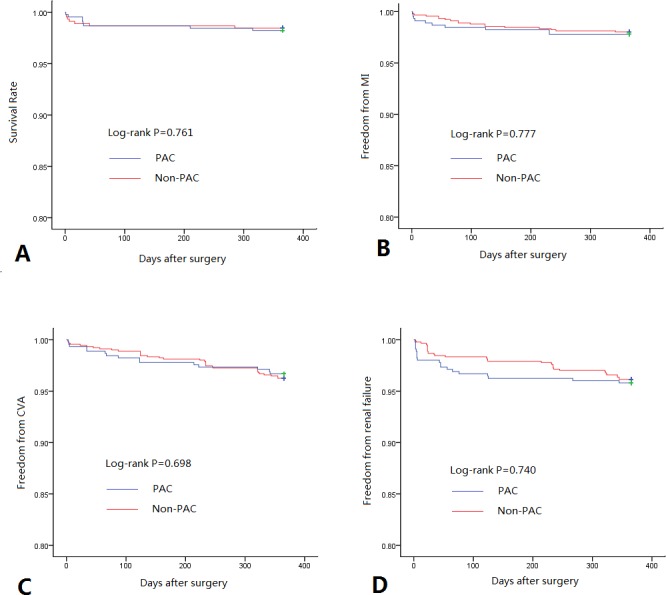
Long-Term Outcomes according to PAC status.A. Survival rate B. Freedom from myocardial infarction (MI) C. Freedom from cerebrovascular accident (CVA) D. Freedom from renal failure.